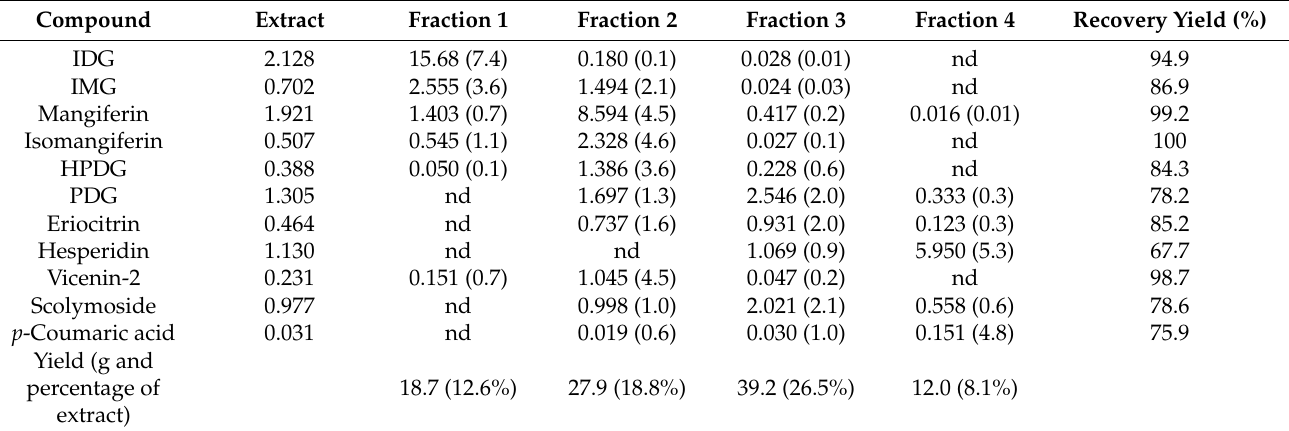
Table 1. Phenolic content (g/100 g) of a green Cyclopia subternata hot water extract and four fractions (including enrichment factors a in brackets), from large-scale fractionation on XAD